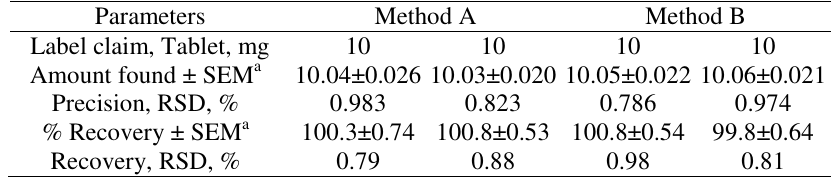
Table 2. Summary of validation